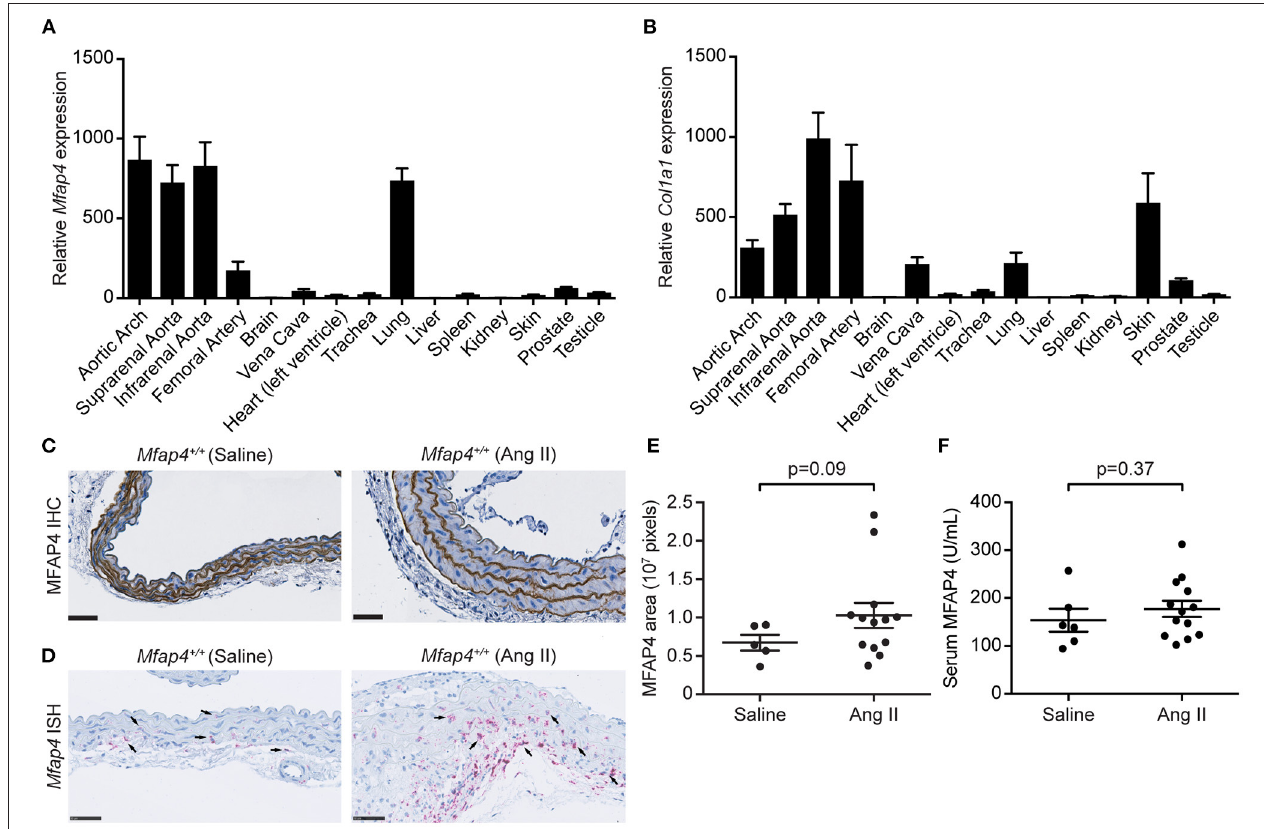
FIGURE 1 | MFAP4 expression in normal aorta and AAA tissue. (A,B) Quantitative real-time PCR analysis of (A) Mfap4 and (B) Col1a1 mRNA transcripts in C57BL/6N mouse tissues ( n = 7). Expression levels are normalized against eukaryotic 18S rRNA and presented as means + SEM. (C,D) Representative images of (C) MFAP4 immunohistochemical staining (IHC) and (D) Mfap4 in situ hybridization staining (ISH) in abdominal aortic sections in saline-infused and Ang II-infused ApoE − / − ( Mfap4 + / + ) mice. Black arrows indicate examples of positive cells. n = 5–13. Scale bar = 50 µ m. (E) Semi-quantitation of MFAP4 IHC staining intensity in the aortas of saline- and Ang II-infused ApoE − / − mice. (F) MFAP4 concentration in serum from saline- and Ang II-infused ApoE − / − mice. Data are analyzed with Mann-Whitney U